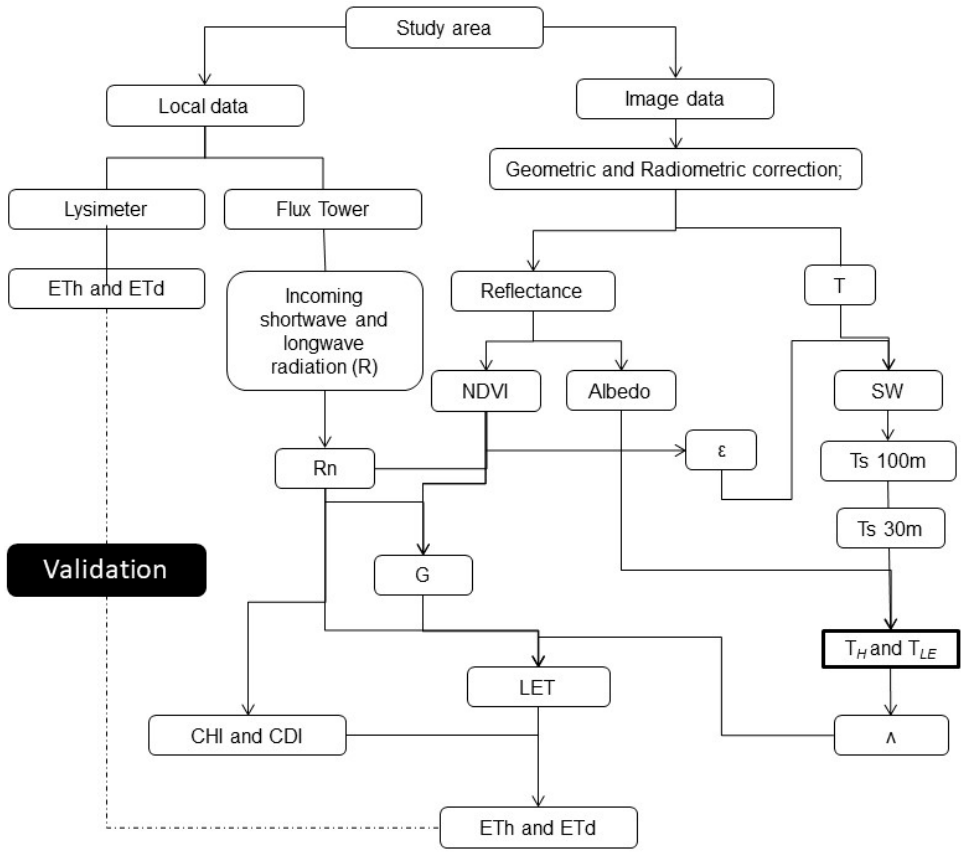
Figure 1. Flowchart of the main steps of the proposed methodology for ET retrieval and validation from Landsat 8 data.